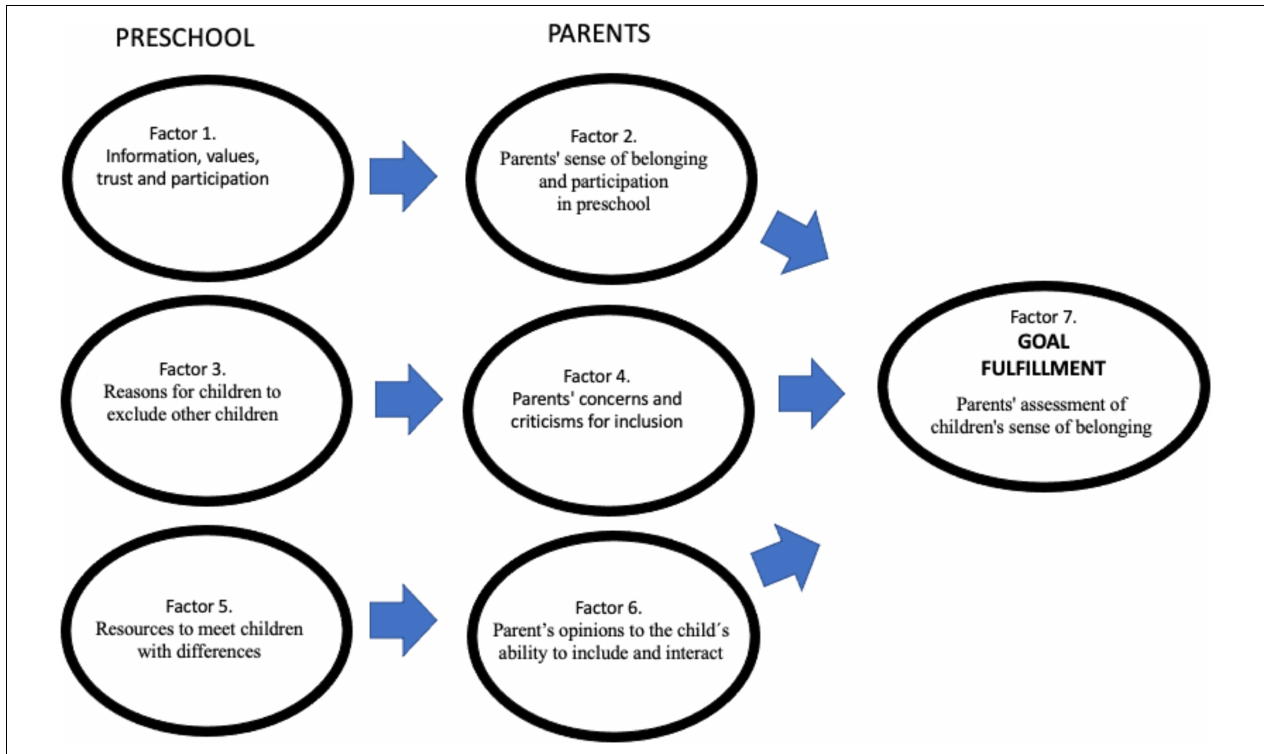
FIGURE 1 | Survey design, where goal fulfilment is evaluated based on sex significant aspects. TABLE 1 | The seven question areas/factors represented in the survey.